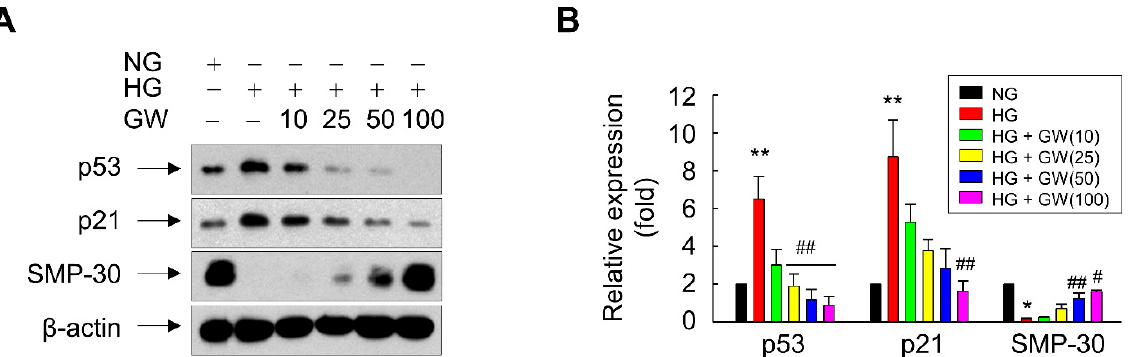
Figure 2. Ligand-activated PPAR δ , but not PPAR α or PPAR γ , attenuates HG-triggered senescence of ARPE-19 cells. ( A , B ) Cells pretreated with WY-14643 (WY, 10 µ M), GW501516 (GW, 100 nM), or rosiglitazone (Rosi, 10 µ M) were exposed to NG (5.6 mM) or HG (30 mM). After incubation for 48 h, SA β -gal staining was performed ( A ) and SA β -gal-positive cells were quantified ( B ). Cells from at least six randomly chosen fields were scored ( n = 100 per group). Scale bars indicate 100 µ m. Quantitative data are expressed as means ± S.E. ( n = 6). * p < 0.01 compared with the NG-treated group. # p < 0.01 compared with the HG-treated group.